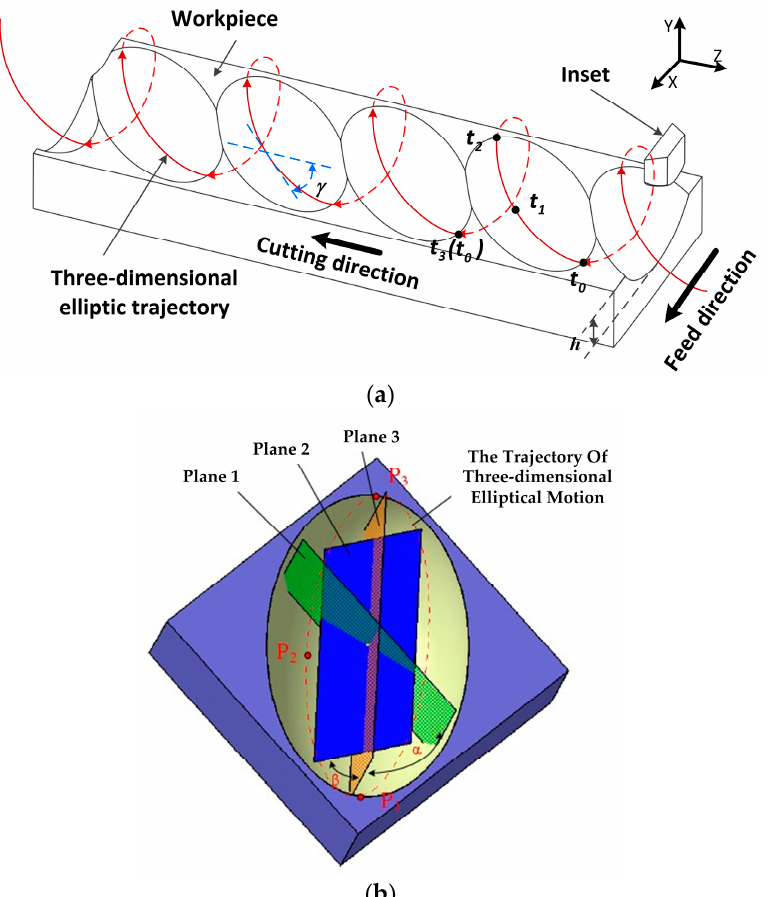
Figure 1. Principle of the non-resonant three-dimensional elliptical vibration cutting (3D-EVC) technique. ( a ) Cutting process of the non-resonant three-dimensional elliptical vibration cutting (3D-EVC); ( b ) Individual cutting marks in a single cutting cycle.